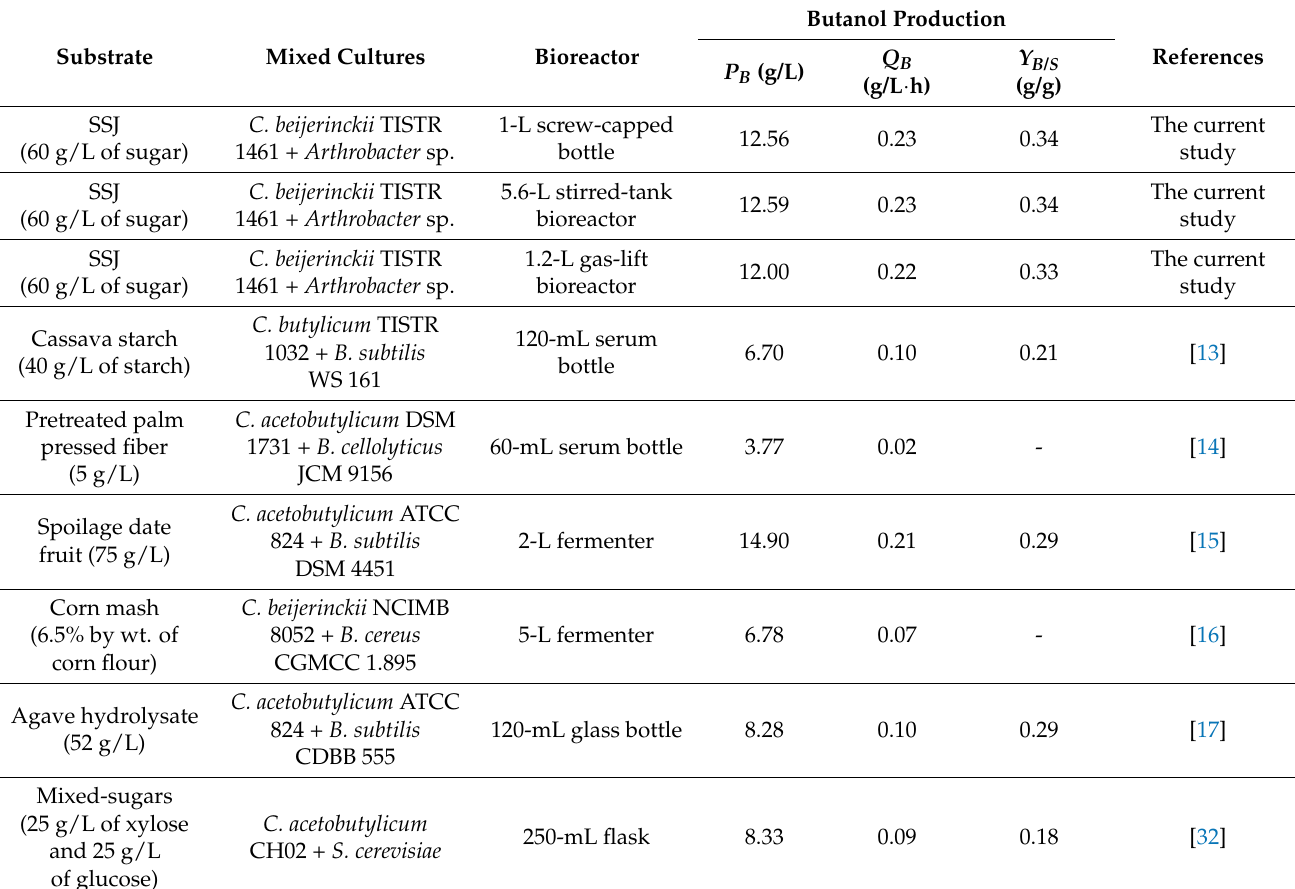
Table 3. Batch butanol production by mixed cultures in earlier